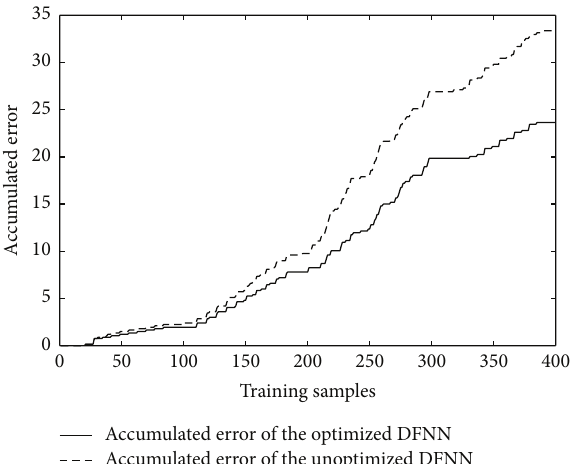
Figure 14: BP neural network confusion matrix for testing samples.